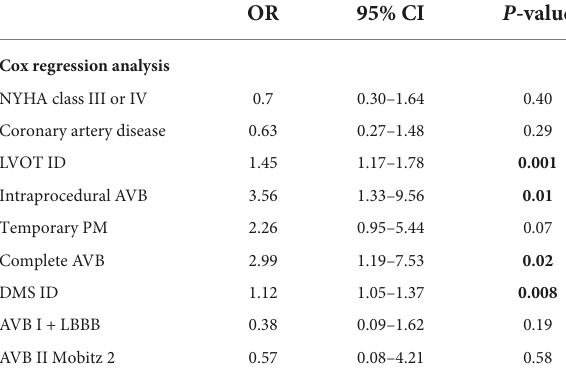
TABLE 3 Variables associated with severely impaired AV conduction at Cox regression